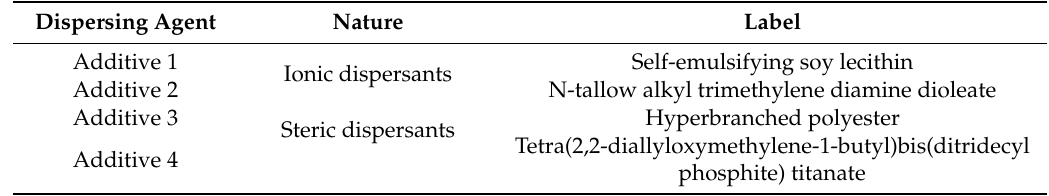
Table 2. Chemical nature of the dispersing agents